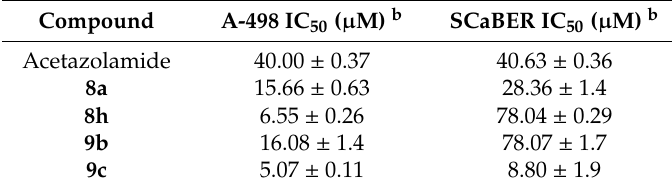
Table 2. In-vitro a data of the MTT cell proliferation assay for the bumetanide compounds. Compound